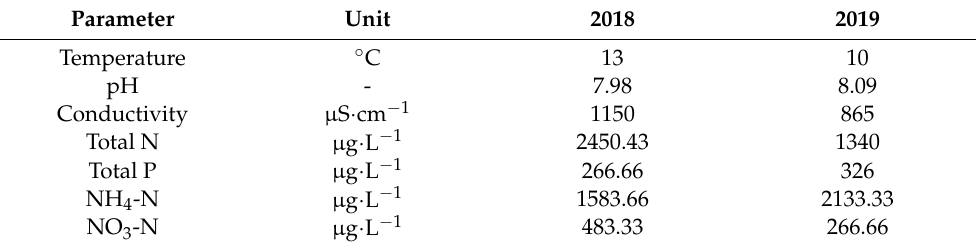
Table 4. Physicochemical properties of processed wastewater (WW) used for irrigation during two growing seasons, 2018 and 2019 (n = 3). Parameter